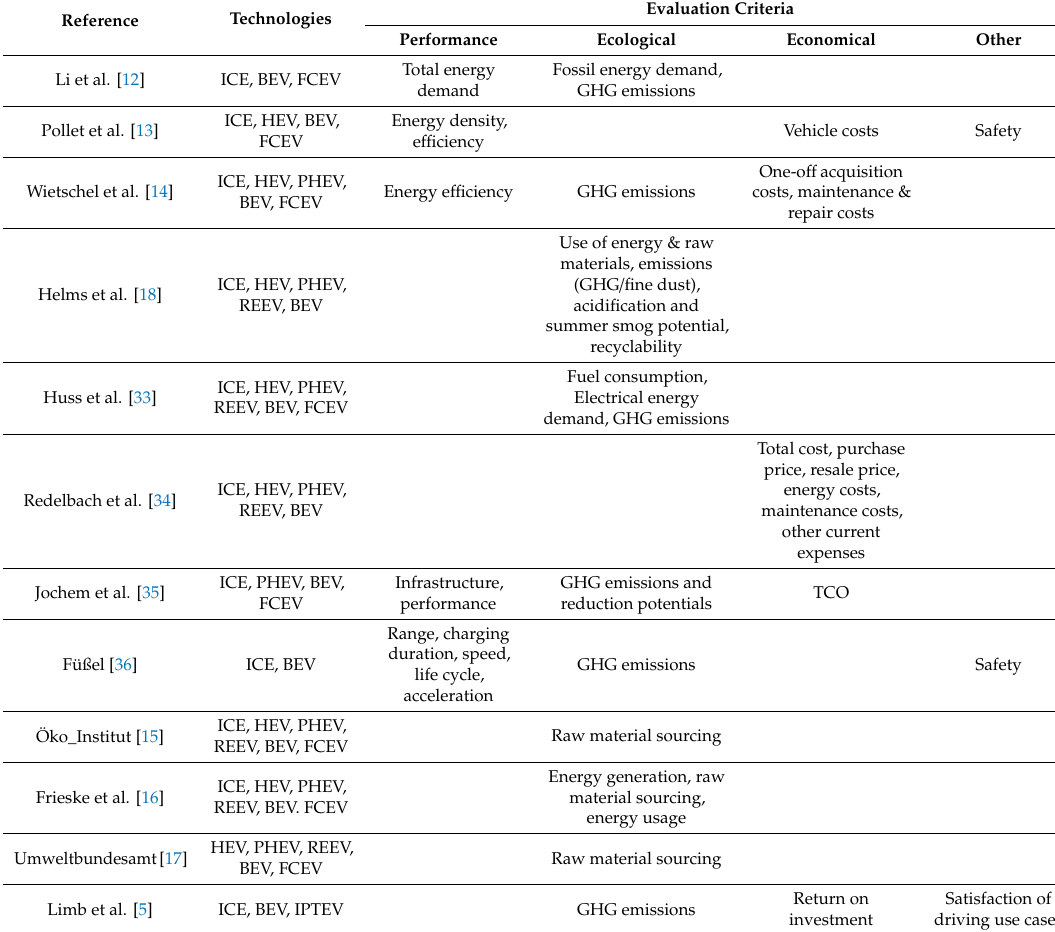
Table A1. Selected studies comparing alternative powertrain